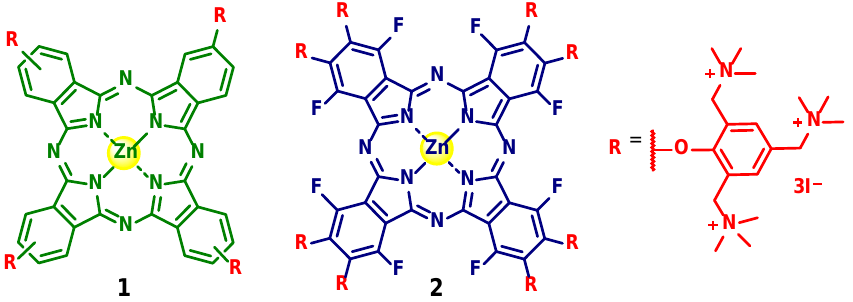
Figure 4. Structures of tetra- and octasubstituted zinc(II) phthalocyanines 1 and 2 . Irradiation in the absence of PS did not induce a decrease in the concentration of viable F. oxysporum conidia; similarly, no decrease was observed in the absence of light and the presence of PS (LC, DC 1 and DC 2 , Figure 2). After 60 min of irradiation (light dose of 486 J · cm − 2 ), with concentrations of 5 and 10 µ M, the inactivation caused by either PS 1 or PS 2 was negligible (<1 log 10 ; Figure S4). In order to attain complete inactivation, higher concentrations of PS (20, 40, and 60 µ M) were tested. In this case, with the same irradiation time and 40 or 60 µ M of PS 1, it was possible to reduce the concentration of viable spores to the method’s quantification limit, taking this result as complete inactivation (Figure 2). With 20 µ M and the equivalent energy dose, the inactivation corresponded to a 2 log 10 reduction in the concentration of viable conidia. In the case of PS 2 (Figure 2), an even higher concentration may be required, since the concentrations of 20, 40, or 60 µ M caused reductions of 2, 3, and 5 log 10 in the concentration of viable conidia, respectively, with a light dose of 486 J · cm − 2 . Overall, our results confirmed that ammonium PSs above